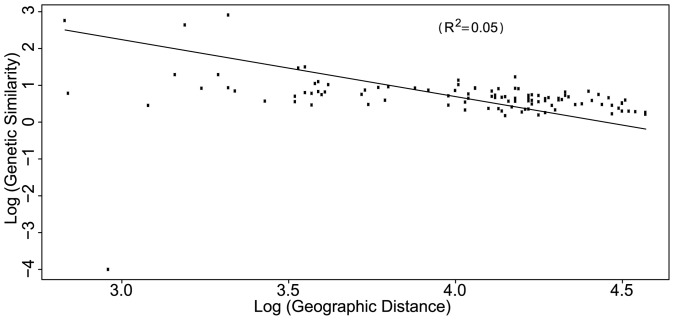
Isolation-by-distance and non-equilibrium conditions between dispersal and genetic drift.The logarithm of genetic similarity is plotted against the logarithm of geographic distance among population pairs [26]. Estimations of slope, intercept and R2 of the relationships were calculated using Reduced Major Axis (RMA) regression [83]. The RMA regression explained only 5% of the variance in the whole distribution area of Abies cilicica in Lebanon. Analysis was performed in ibdws
[81].